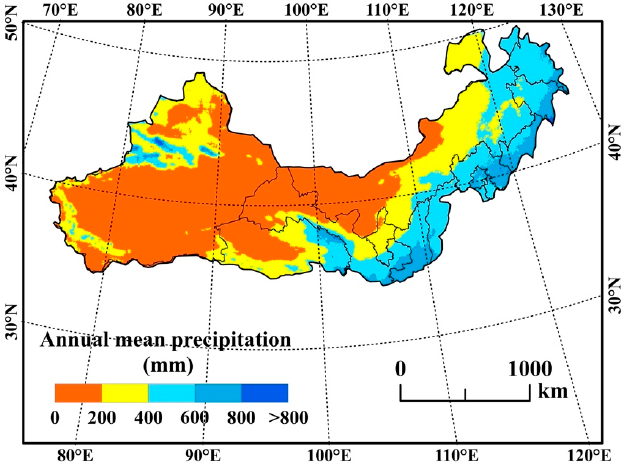
Figure 2. The five precipitation zones according to equal intervals of 200 mm in the annual mean precipitation in northern China from 2007 to 2017.